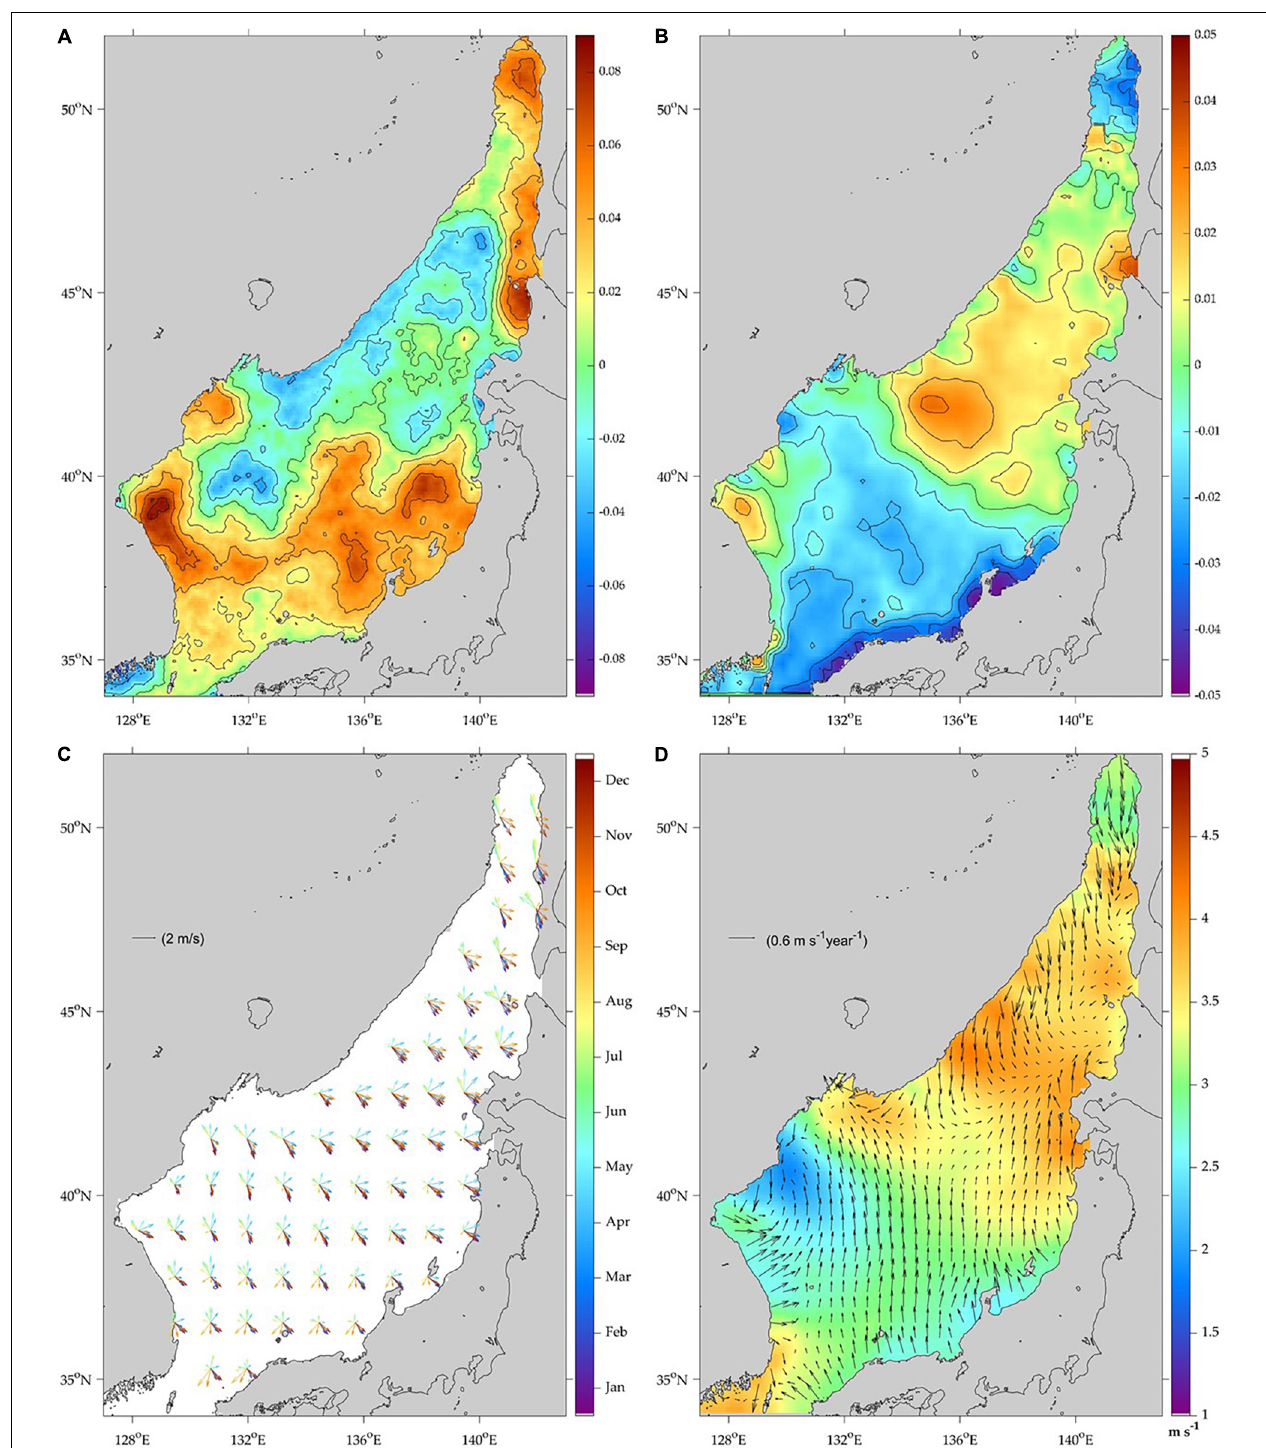
FIGURE 9 | Spatial distributions of the temporal trends in (A) sea surface temperatures ( ◦ C year − 1 ) and (B) sea surface wind speeds (m s − 1 year − 1 ), (C) monthly variations in directional wind vectors (m s − 1 ) from January to December, and (D) directional trends in wind vectors (m s − 1 year − 1 ) in the East Sea (Japan Sea) from 2003 to 2020, where the background image represents the mean wind